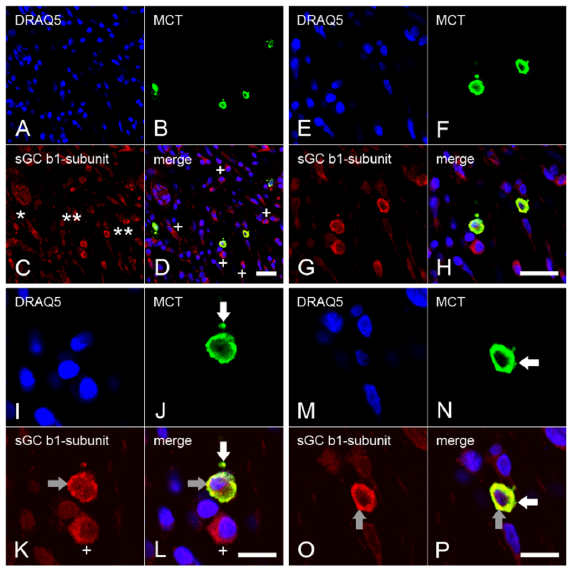
Figure 4. Colocalization of the β 1 subunit of sGC with MCT in mast cells of chronically inflamed human dental pulp. Numerous inflammatory cells with DRAQ5 nuclear staining are present in the overview images of the chronically inflamed dental pulp ( A ). MCT ( B ) colocalizes with sGC β 1 subunit ( C ) in a subpopulation of the inflammatory cells with strong (( C ), two asterisks) and weak (( C ), one asterisk) immunostaining intensities ( D ). In another subpopulation of cells that are MCT negative, the sGC β 1 subunit is apparent (+ character in D , K , L ). In the detailed images, the colocalization of MCT with the sGC β 1 subunit in the cytoplasm of the mast cells is apparent ( E – P ). In mast cells, the localizations of MCT ( J , L , N , P ) are shown with white arrows, while the grey arrows show the β 1 subunit of sGC ( K , L , O , P ). Scale bars: A – H = 20 µ m; I – P = 10 µ